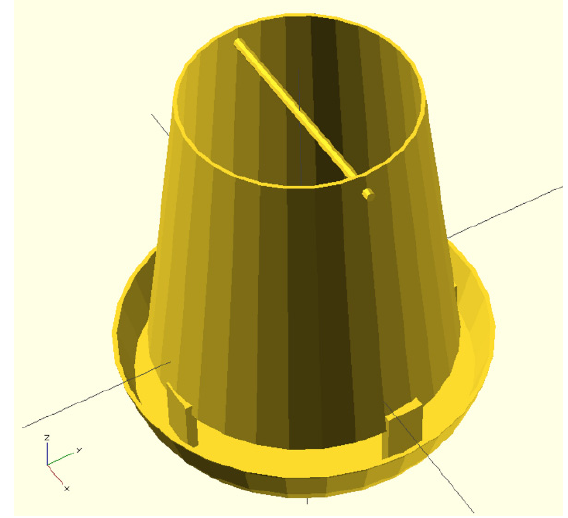
Figure 7. Rendering of OpenSCAD solid model for the chicken feeder.